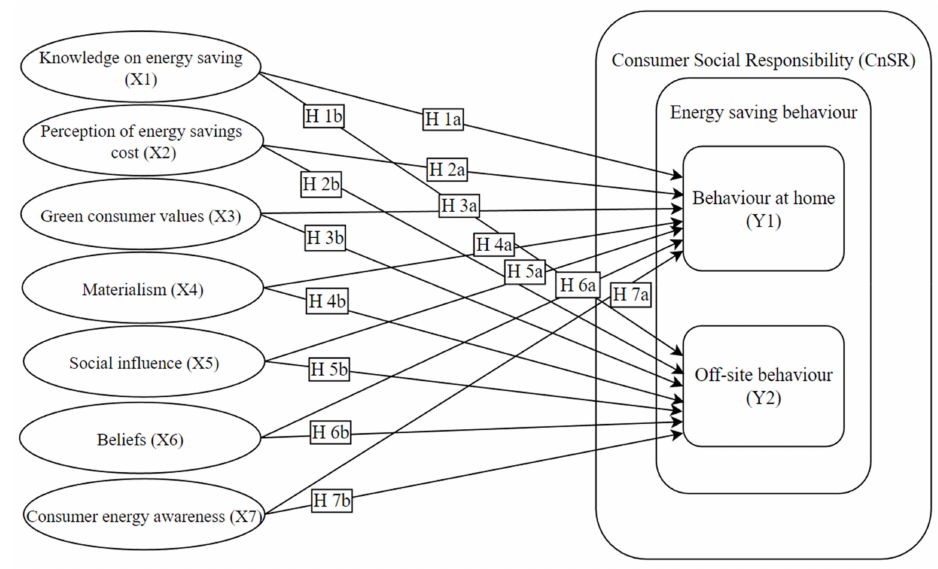
Figure 1. Conceptual research model. Source: Own